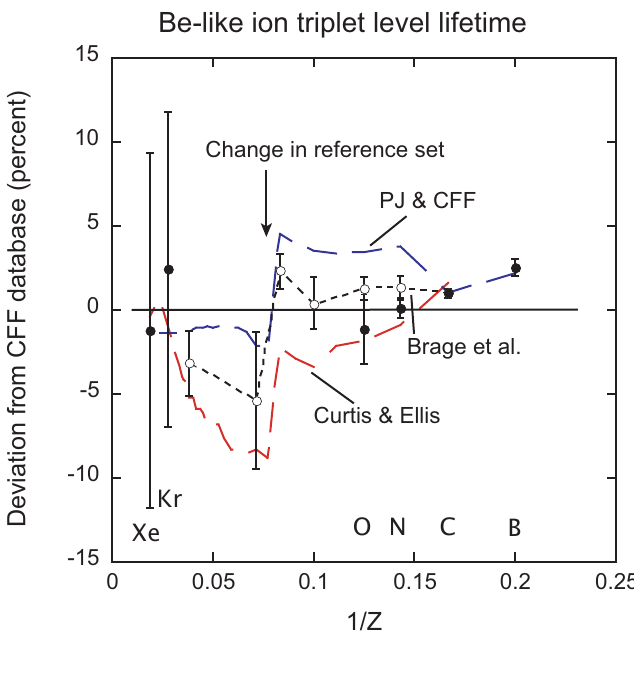
Figure 5. Lifetime of the 2s2p 3 P o level in Be-like ions (intercombination decay) displayed 1 as the relative deviation from the computational web resources (MCHF/MCDHF collection) made available by Froese Fischer and Tachiev [28]. A problem lies in the only partial coverage by any given computation, and therefore one cannot refer all of the available measurements and computations to a single reference data set. Because of this, the trends shown all suffer a step function (by 7%) above Ne ( Z = 10 ), because this is where one of the references ends and the comparison changes to another one. The only continuous reference data set would have been the one derived by a semiempirical averaging procedure applied by Curtis and Ellis [29] (broken red line) to computations and measurements, which thus represents a secondary trend. The broken blue line refers to computations by Jönsson and Froese Fischer [27], the short-dash broken black line connects the computational results reported by Brage et al. [131] (open circles, the study has to be lauded for point-by-point estimates of uncertainty). Not all of the experimental data (filled circles) are shown, because for several of them the size of the error bars exceeds the plot